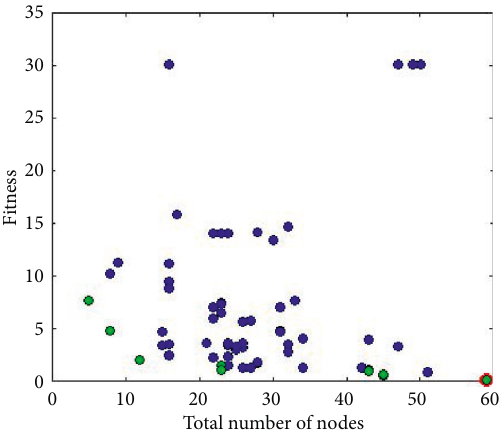
Figure 7: Pop browser for GEP